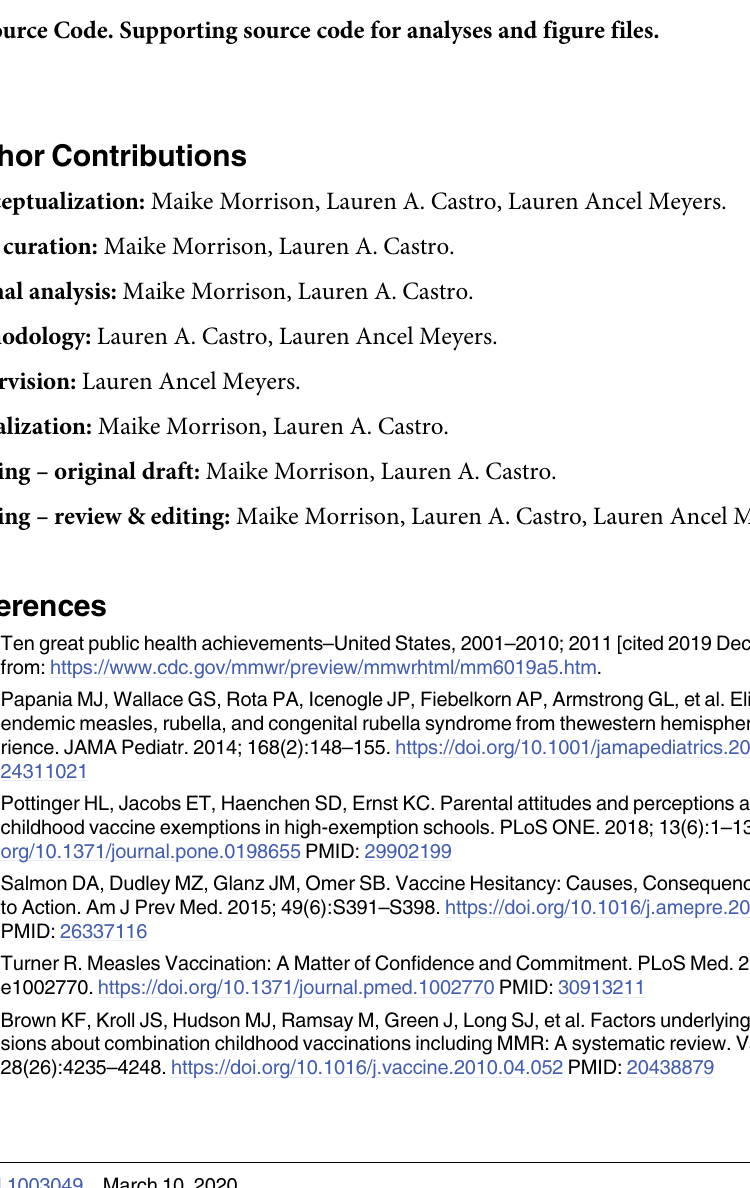
S1 Table. Table of potential socioeconomic and demographic